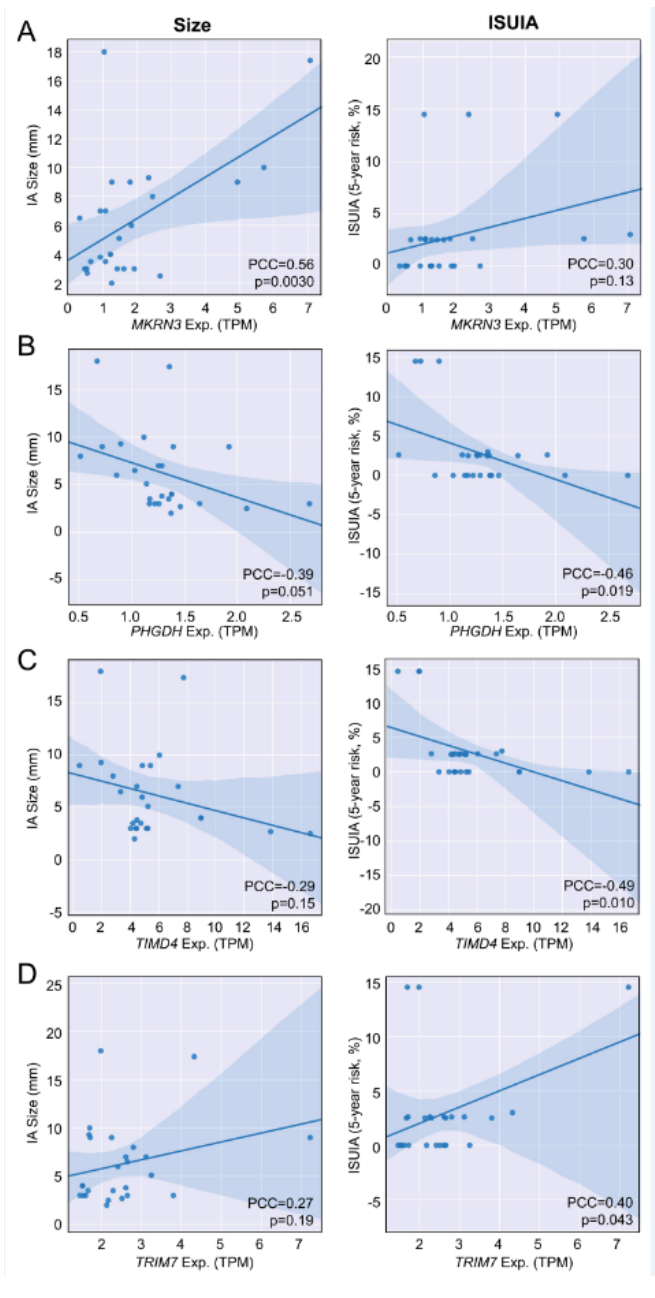
Figure 5. Genes significantly correlated with the IA risk metrics, IA size and ISUIA-defined 5- year rupture risk %. Four genes had an absolute PCC > 0.25 in both correlation analyses, with at least one correlation being significant ( p < 0.05). ( A ) MKRN3 expression was most significantly, positively correlated with IA size (PCC = 0.56, “moderate”). ( B ) PHGDH expression was most significantly, negatively correlated with 5-year risk (PCC = − 0.46, “moderate”). ( C ) TIMD4 expression was also most significantly, negatively correlated with 5-year risk (PCC = − 0.49, “moderate”). ( D ) TRIM7 expression was most significantly, positively correlated with 5-year risk (PCC = 0.40, “moderate”). (Exp. = expression, ISUIA = International Study of Unruptured Intracranial Aneurysms, PCC = Pearson correlation coefficient, TPM = transcripts per